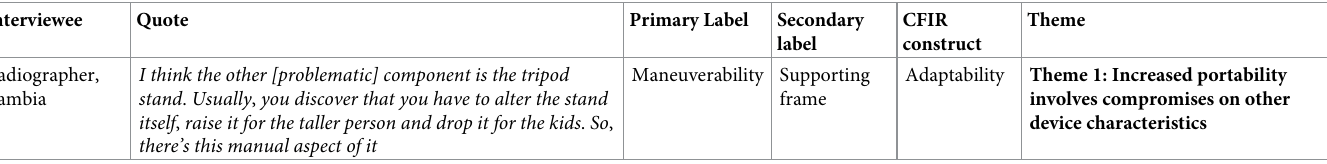
Table 2. An example of the coding